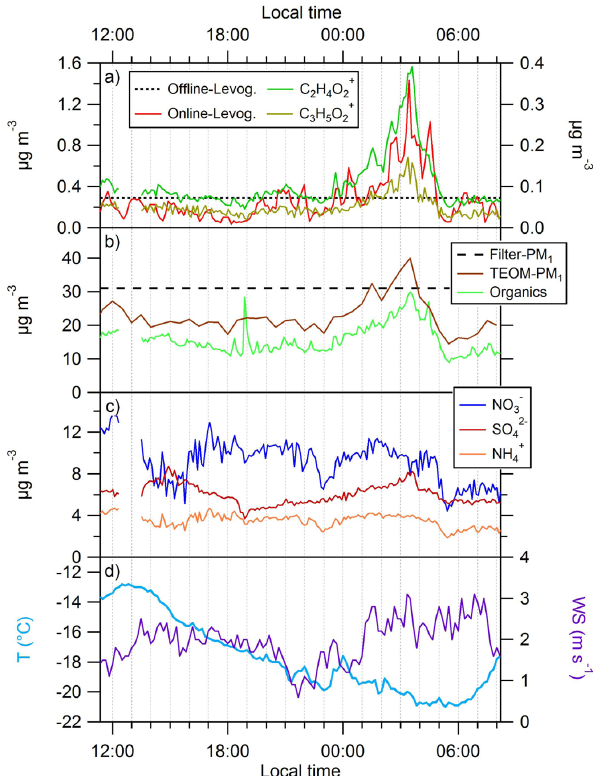
Fig. 9. Concentrations of online levoglucosan with the PILS– HPAEC–MS and offline from the filter sample (left axis) and C 2 H 4 O + and C 3 H 5 O + with the HR-ToF-AMS (right axis) (a) ; 2 2 PM 1 mass with the TEOM and from the filter sample and organ- ics with the HR-ToF-AMS (b) ; nitrate, sulfate and ammonium with the HR-ToF-AMS (c) ; as well as air temperature and wind speed (d) during the filter sampling on 24–25 February